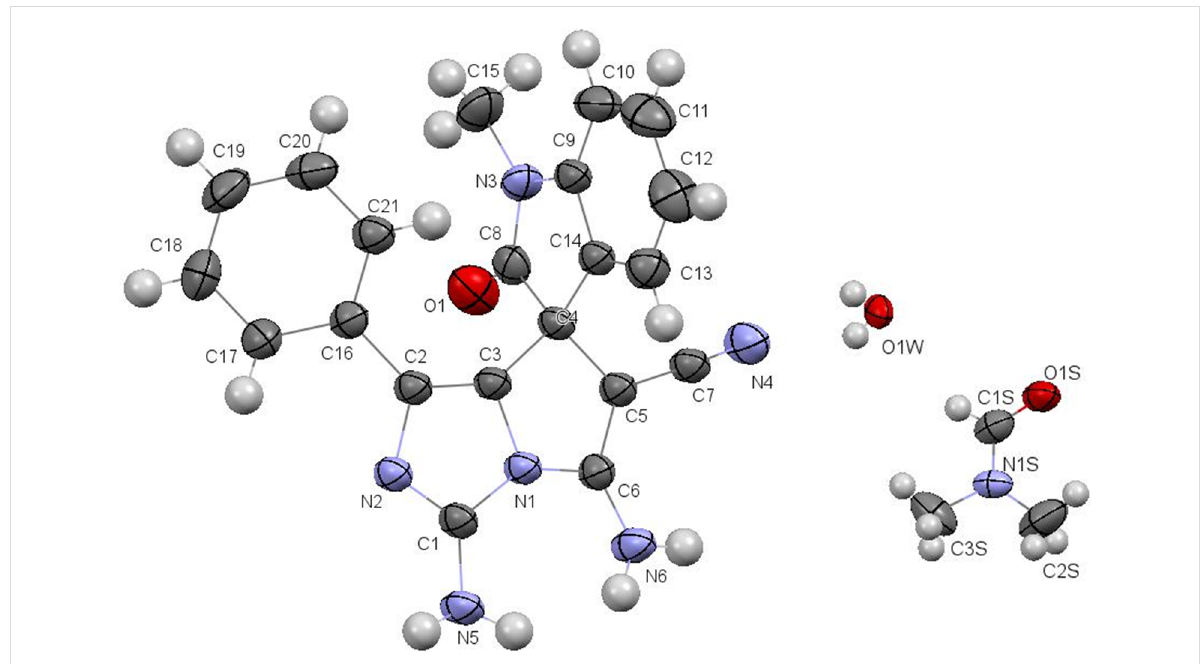
Figure 7: Molecular structure of aminoimidazo[1,2- c ]pyrrole 19a according to X-ray diffraction data. Thermal ellipsoids of atoms are shown at 50% probability level.